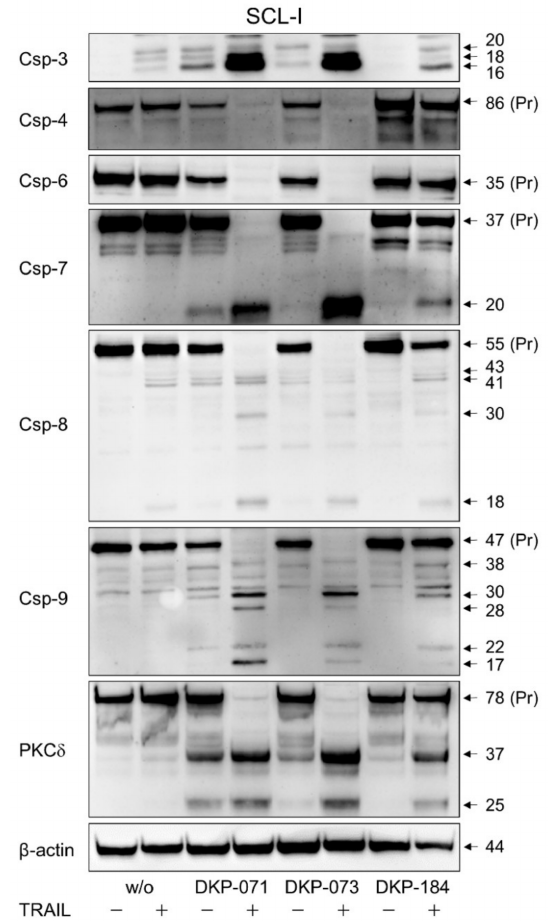
Figure 4. Enhanced caspase activation in course of combined treatment. Protein extracts of SCL-I cells treated for 24 h with indirubins (DKP-071, -073 and -184, 10 µ M), TRAIL (50 ng/mL) or the